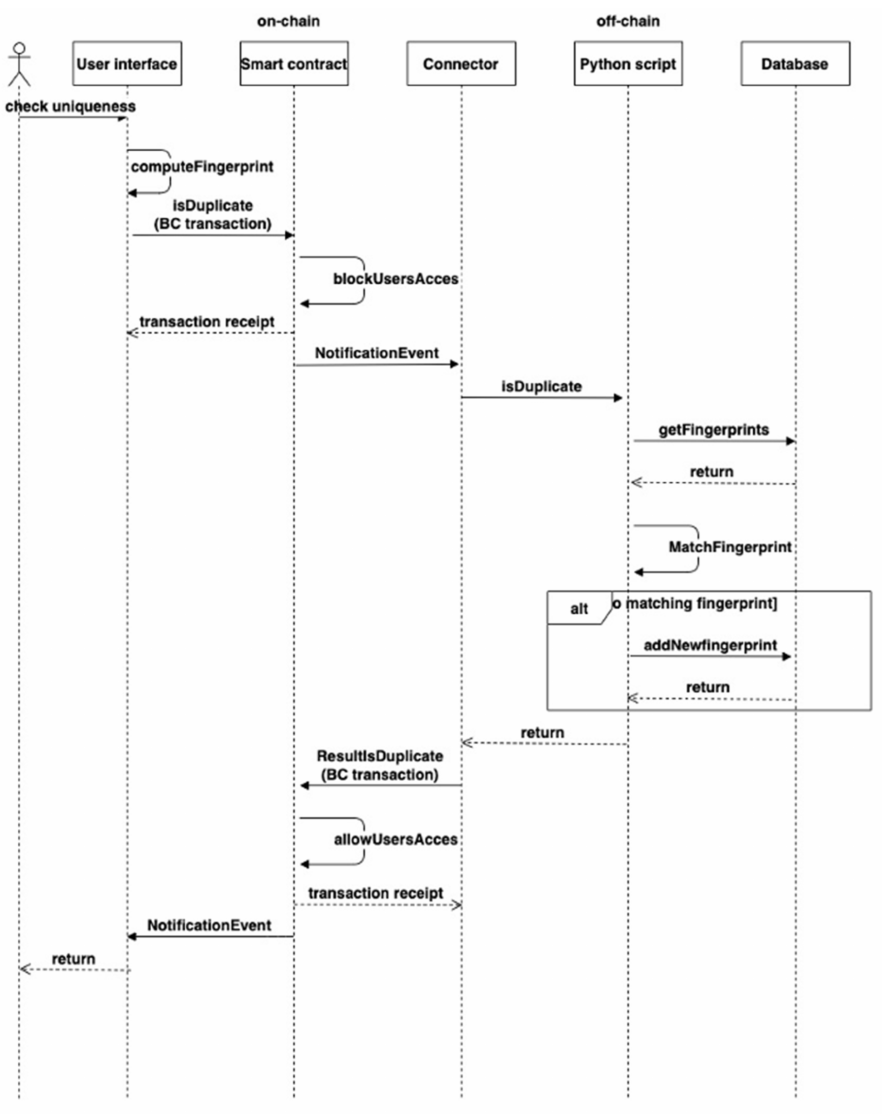
Figure 5. Execution sequence